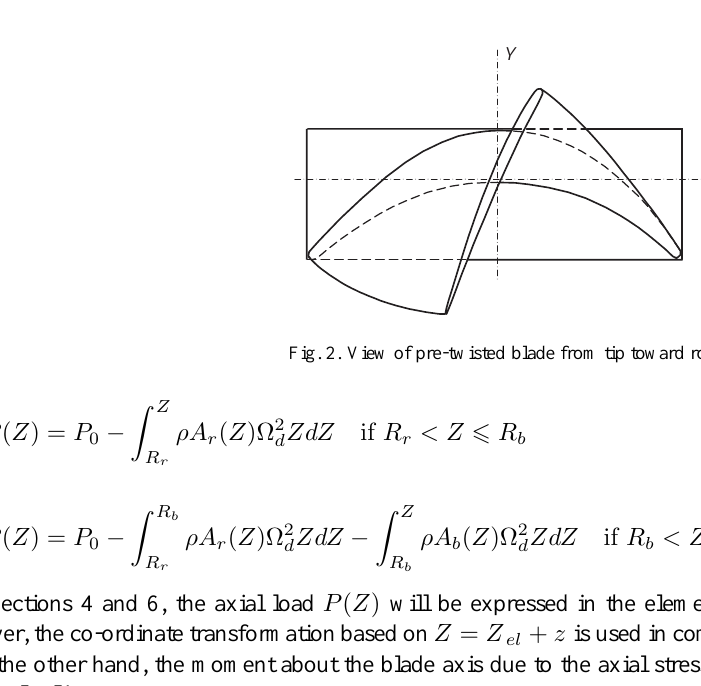
Fig. 1. Finite element modelling under rotation.